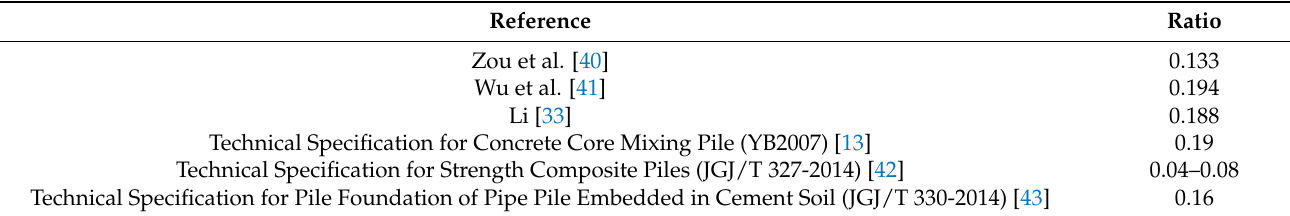
Table 1. The ratio of friction resistance at the inner–outer core interface and the cemented-soil strength.